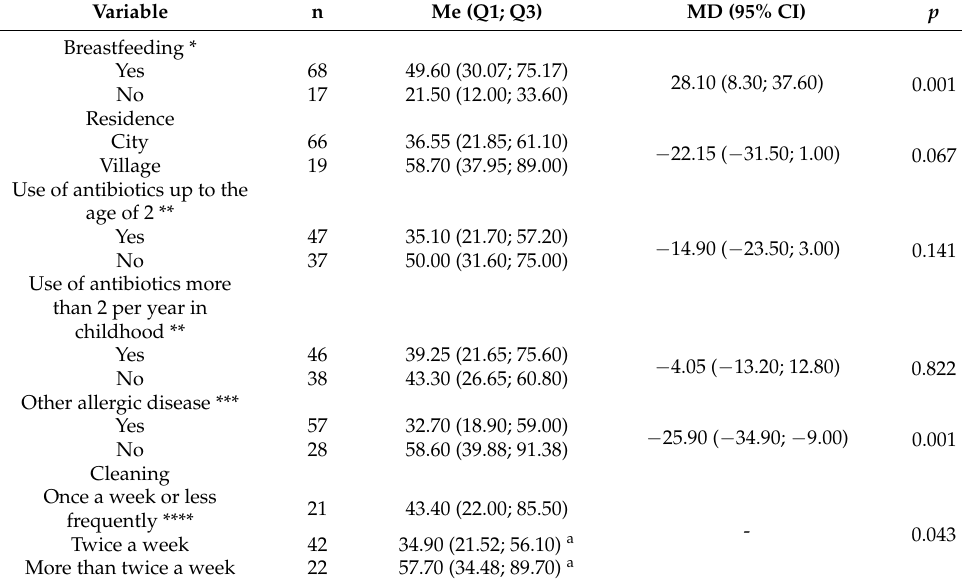
Table 4. Level of FOXP3+ depending on selected environmental factors.